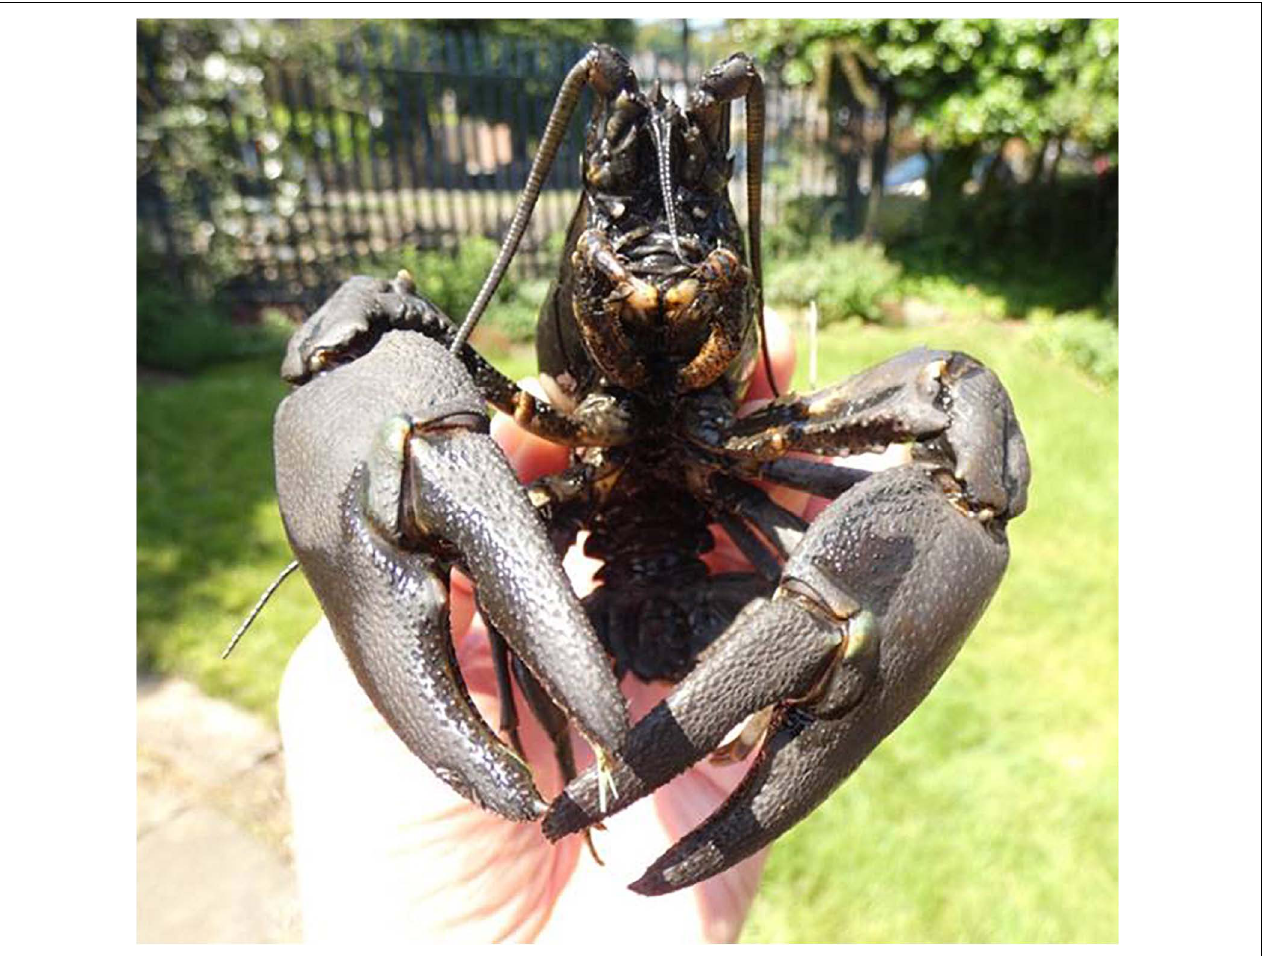
FIGURE 9 | American signal crayfish from the River